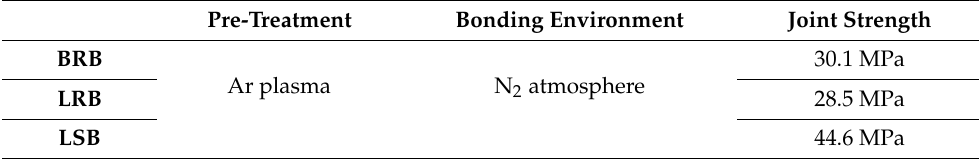
Figure 14. Simulated maximum stress and actual joint shear strength of the LSB, LRB, and BRB. Table 3. Actual joint strength of the BRB, LRB, and LSB subjected to Ar plasma pretreatment (200 W, 50 sccm, and 20 min) and ultrasonic bonding.